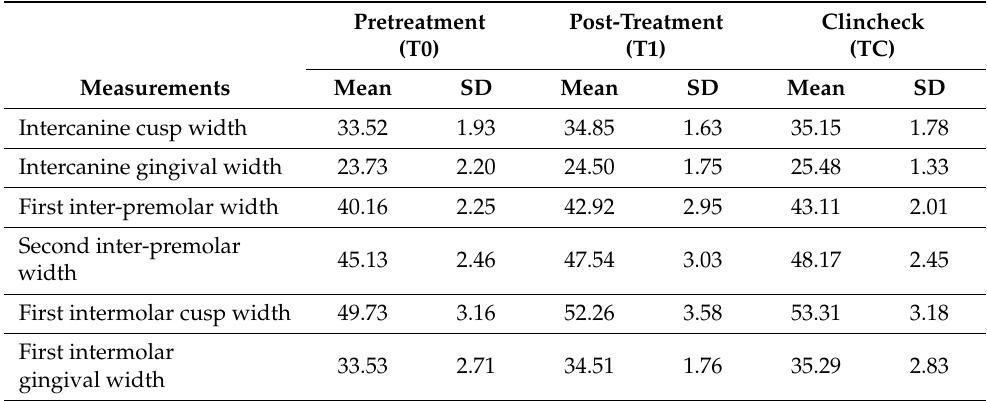
Table 1. Descriptive statistics of the measurements performed pretreatment (T0), post-treatment (T1), and in the Clincheck model